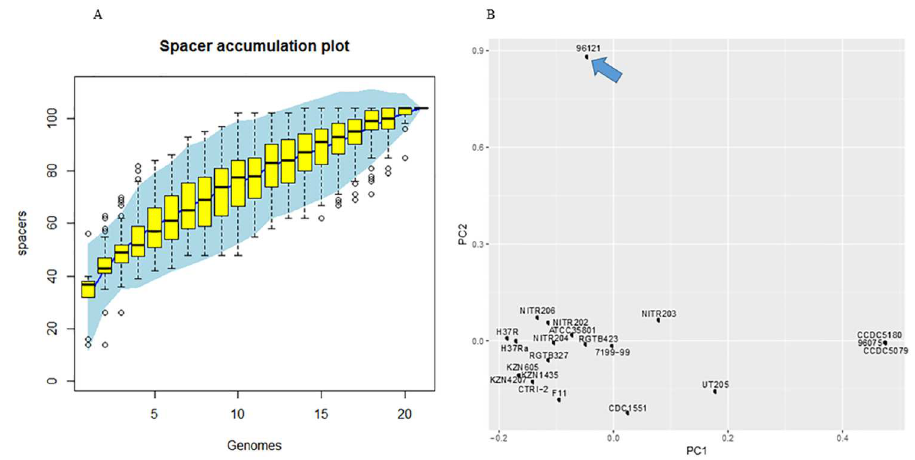
Fig 1. Evolution of CRISPR spacersin complete genomes of 21 M . tuberculosis strains. (A) Accumulation curve of spacers in completegenomesof 21 M . tuberculosis strains. (B) PCA of presenceand absenceof CRISPR spacers in completegenomesof 21 M . tuberculosis strains. The blue arrow indicatesthe positionof Manila family 96121,illustratinga dramatic difference in the composition of spacers in Manila family